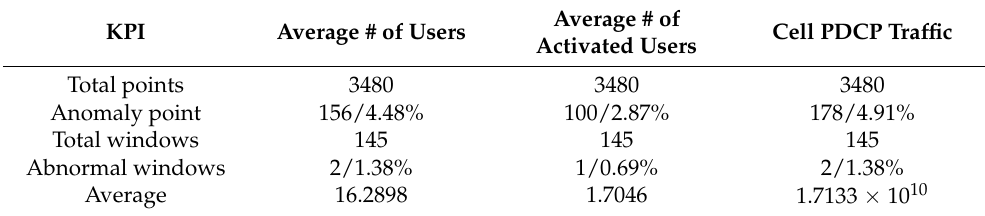
Table 2. Statistics of